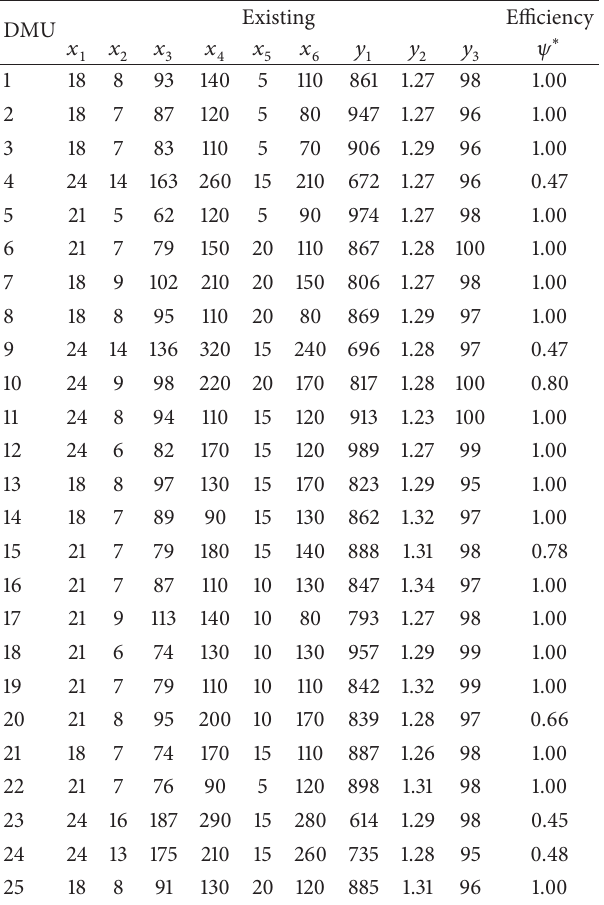
Table 3: The Data and Results Obtained from Model (3) for the Die Press Separation of the Motorcycle-Part